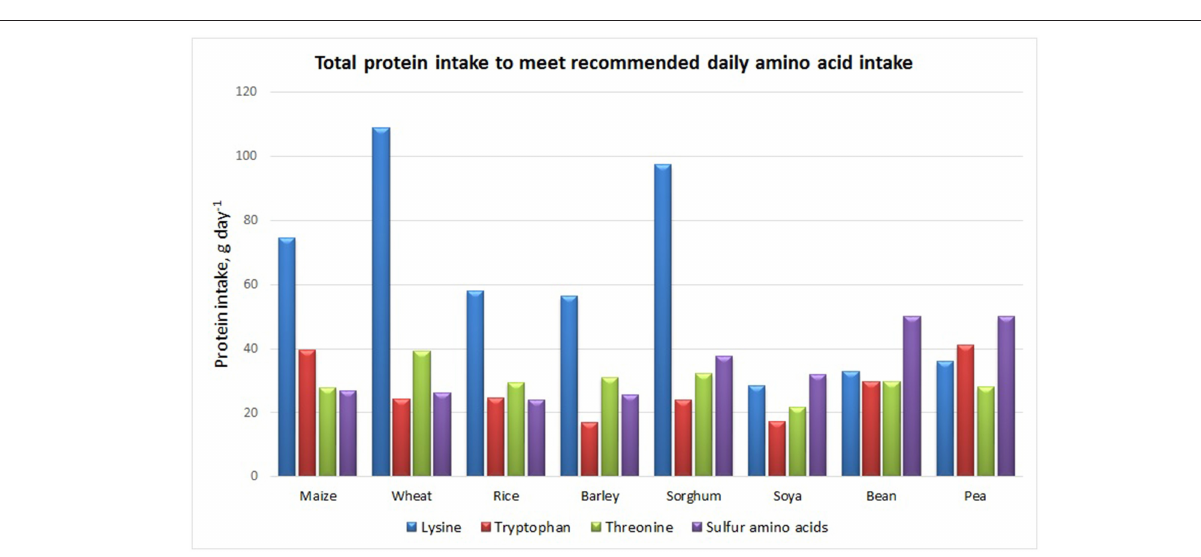
FIGURE 2 | Protein obtained from selected crops corresponding to an amount that would fulfill the daily amino acid requirements of a 70kg adult. Each of the potentially limiting amino acids (lysine, tryptophan, threonine, and sulfur amino acids) is considered separately. The amino acid with the highest required protein intake indicates the first limiting amino acid in each